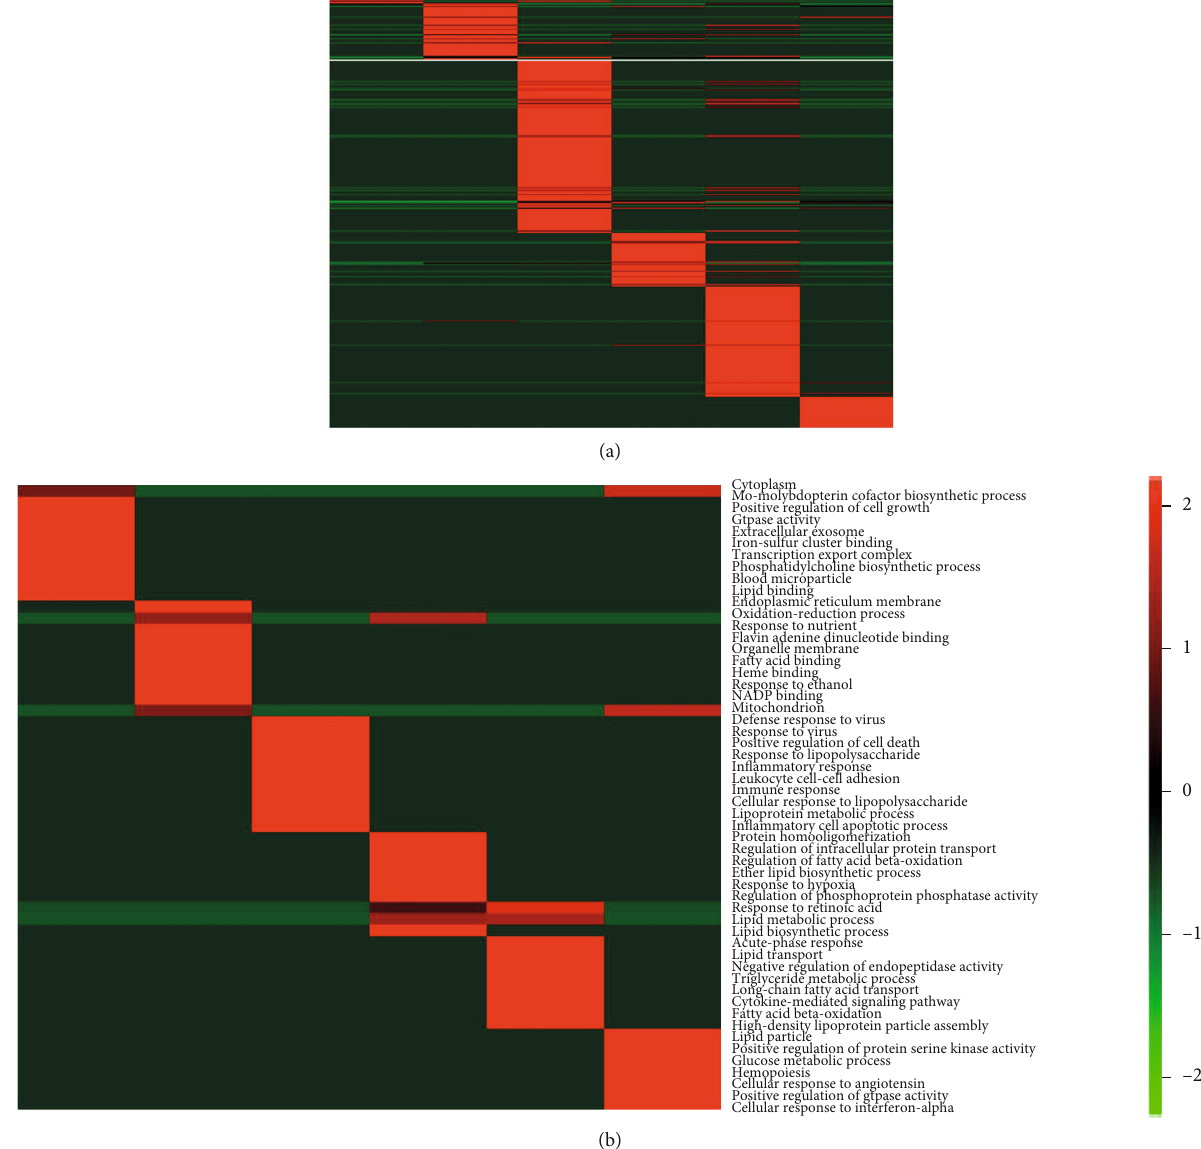
Figure 3: Association of di ff erential genes with functional Gene Ontology (GO) terms. (a) Full enrichment dataset heat map for GO terms from WT and LBP -/- at 0h, 6h, and 24 h after LPS challenge. (b) Ten representative di ff erentially enriched GO